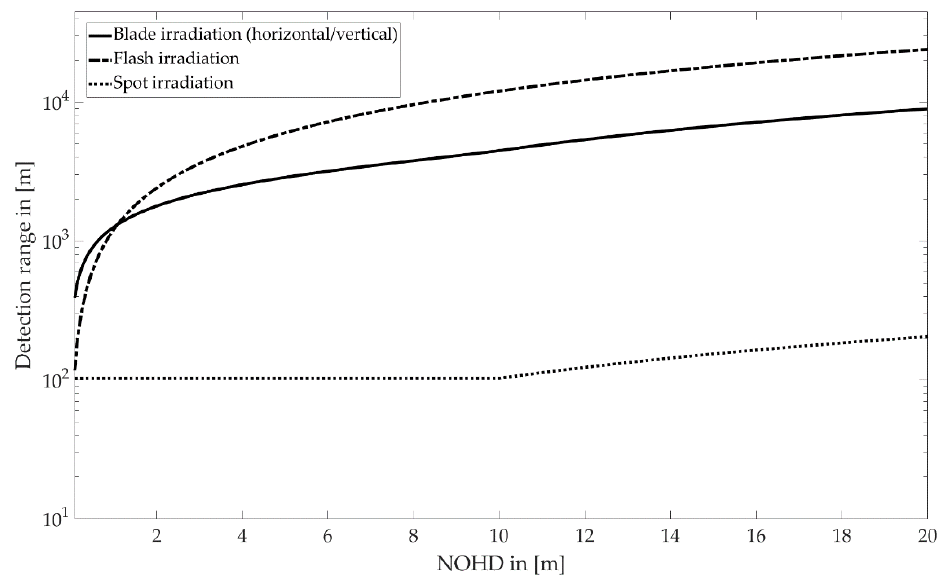
Figure 8. Detection range as a function of the eye safety distance for different LiDAR systems.